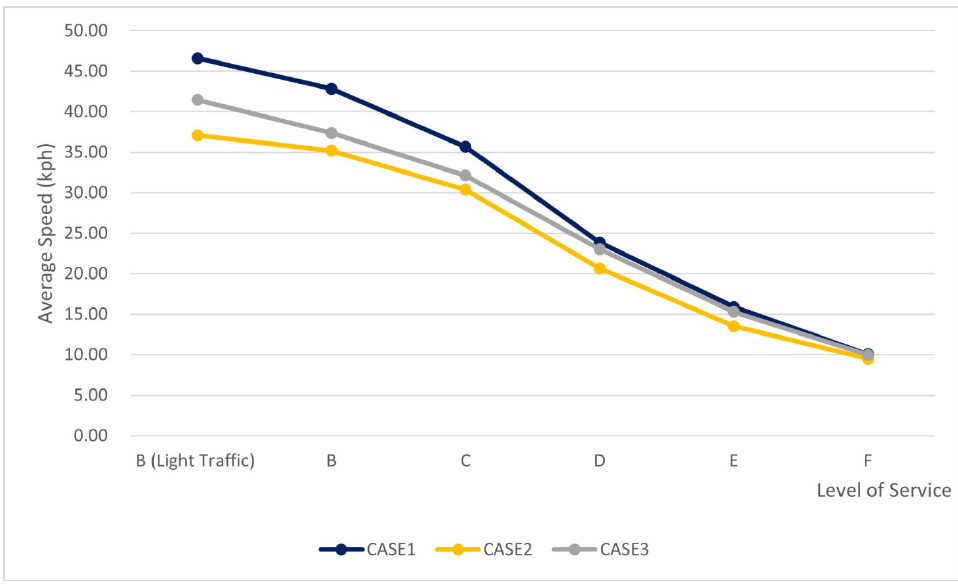
Figure 4. Average speed comparison.